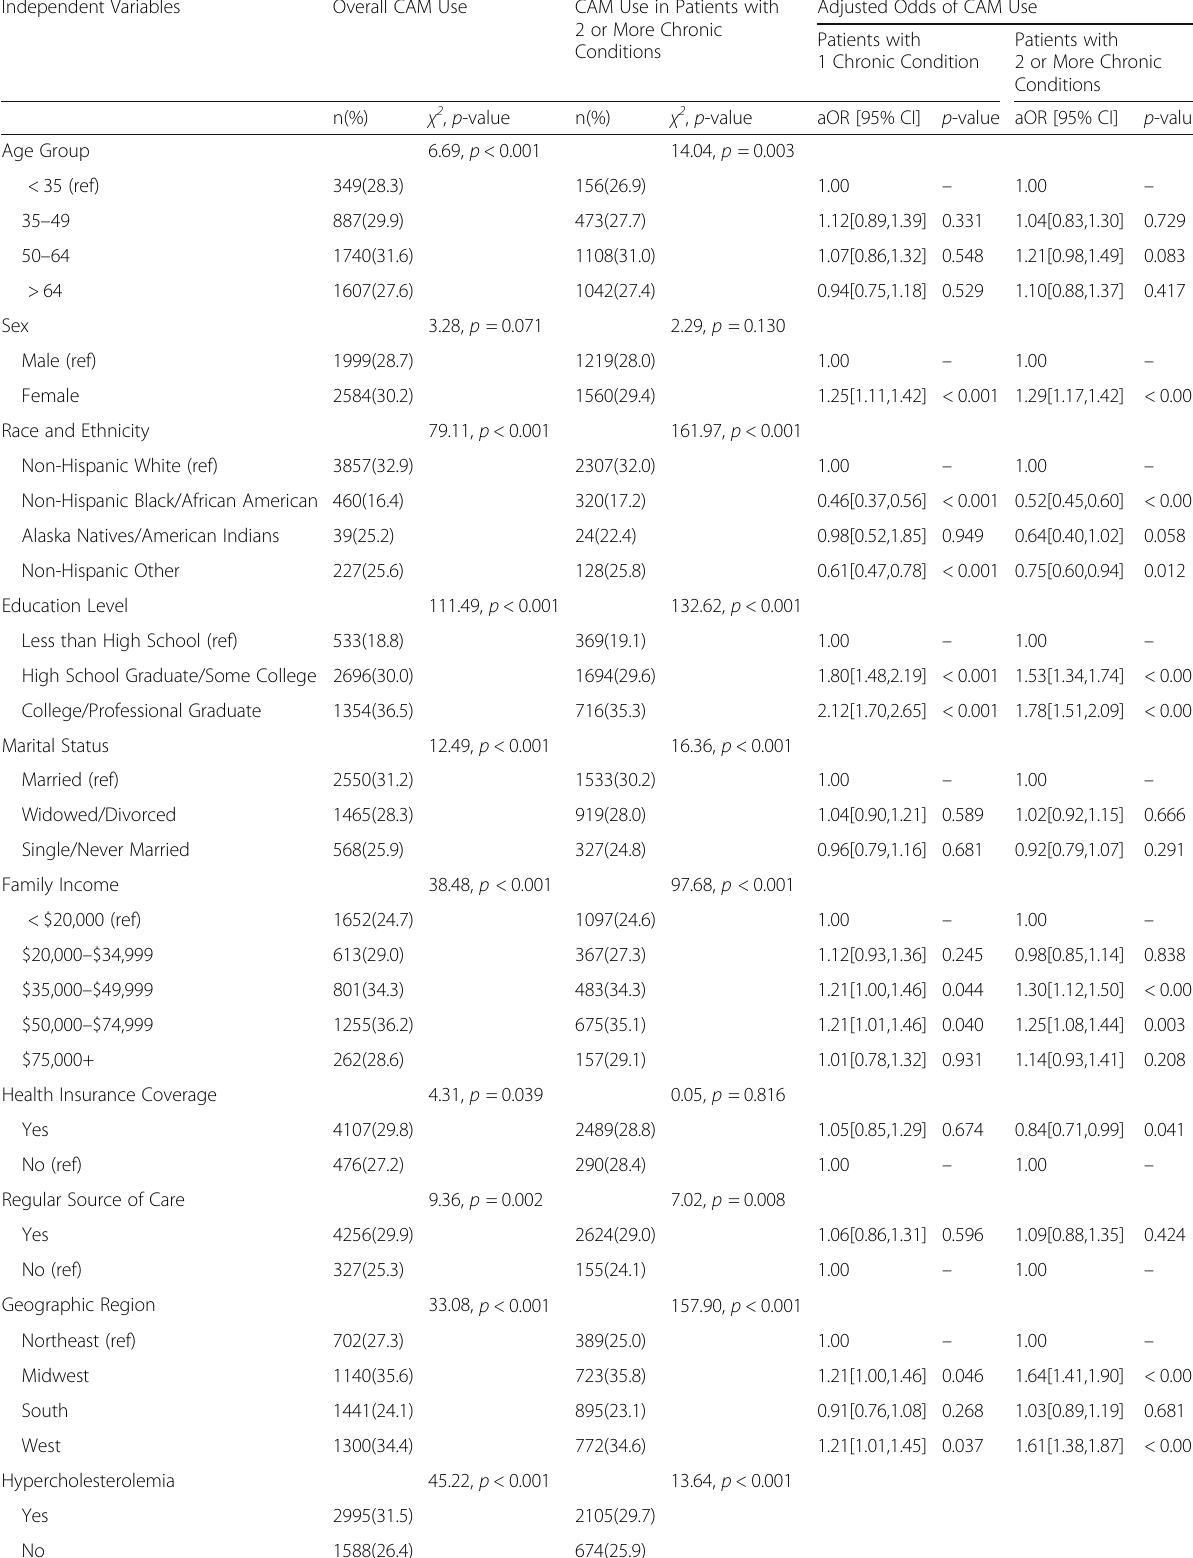
Table 2 Proportions and odds of CAM use among adults with and without